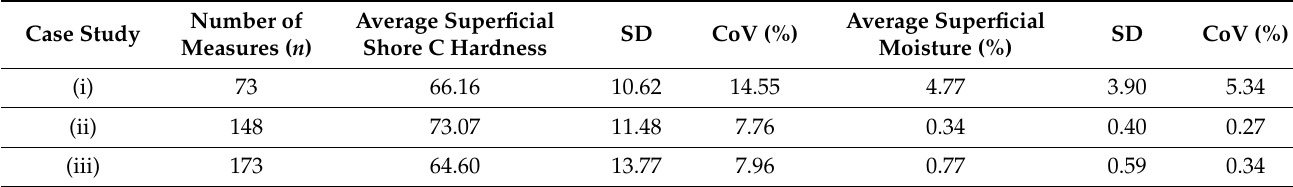
Table 7. Surface mechanical properties.